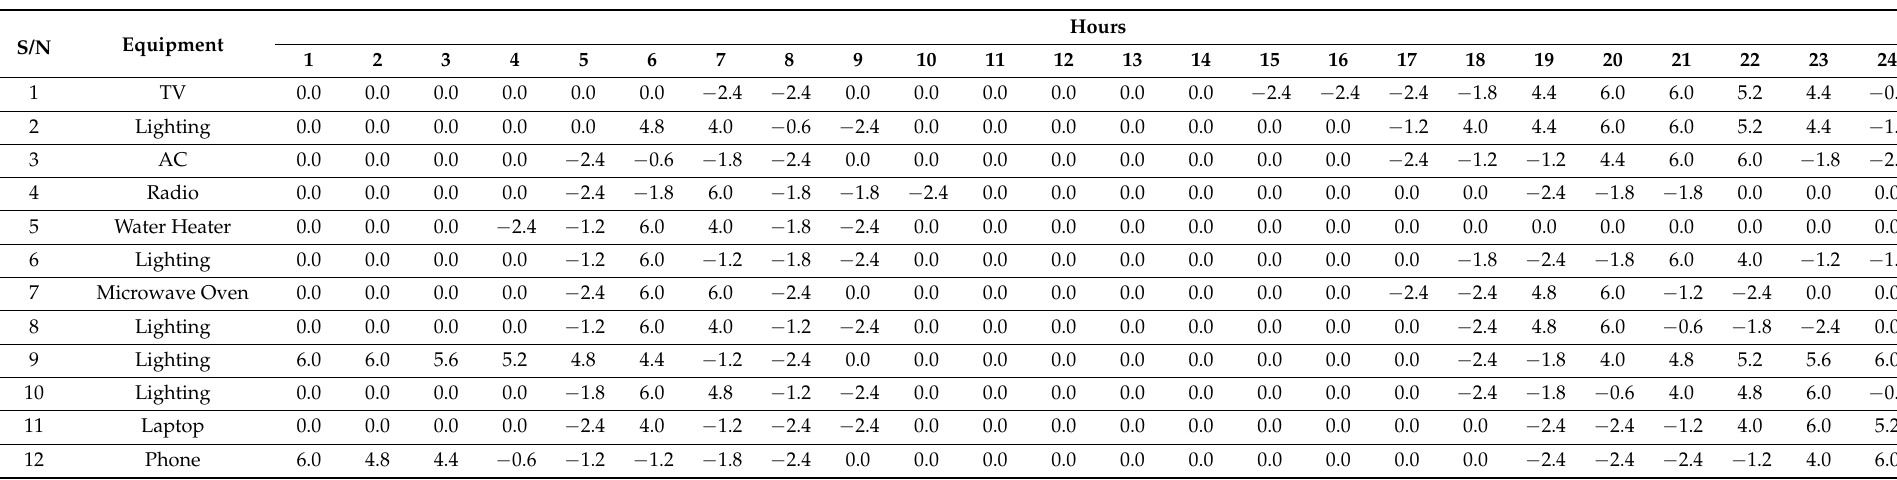
Table 7. Device-based